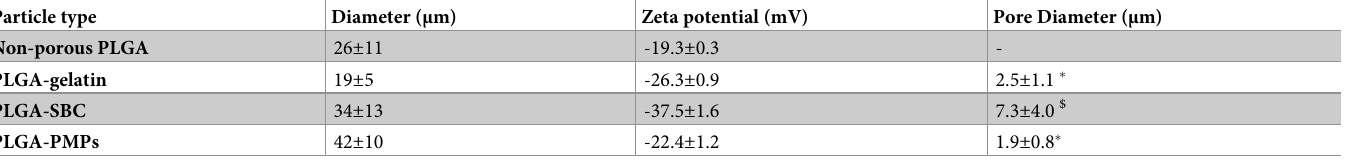
Table 1. Initial characterization of porous particles. Five images were analyzed per